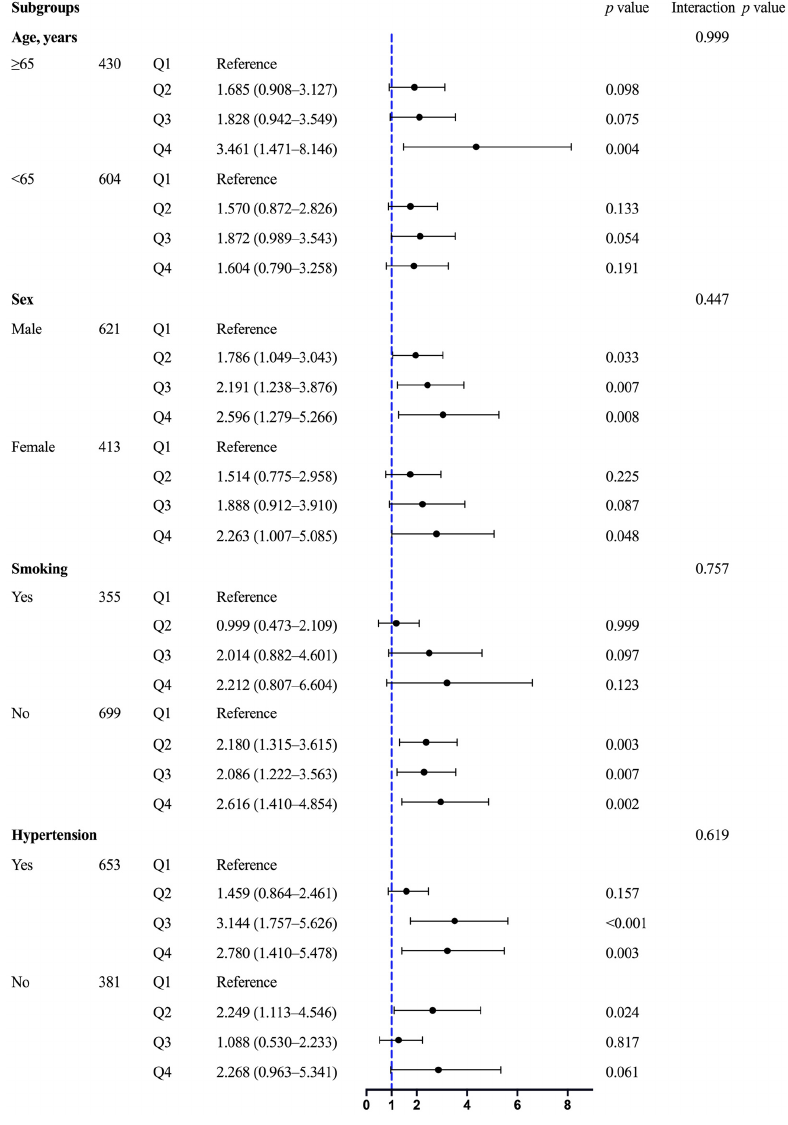
Figure 5. The association between the TyG index and VDD prevalence in subgroups. multivariate logistic regression analyses (adjustments for age, sex, smoking, obesity, hypertension, BMI, SBP, DBP, insulin therapy, hypoglycemic agents’ medication, statin therapy, HbA1c, TC, LDL-C, HDL-C, Scr, UA, and albumin) was used in subgroups based on age ( ≥ 65 or <65 years), sex (male or female), smoking (yes or no), hypertension (yes or no).